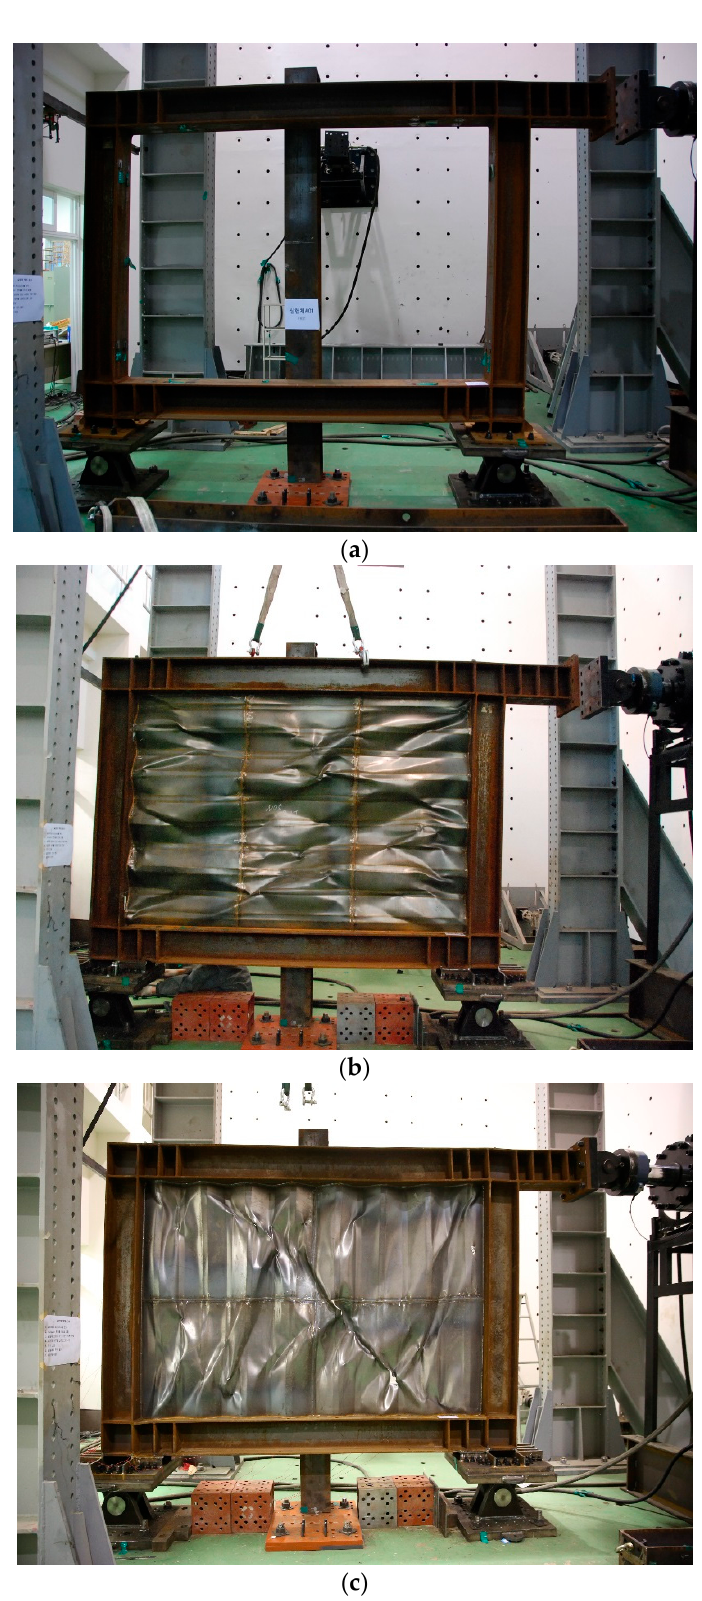
Figure 7. State of the specimens at ultimate stage: ( a ) FR-00; ( b ) FR-TR-V; ( c ) FR-TR-H.